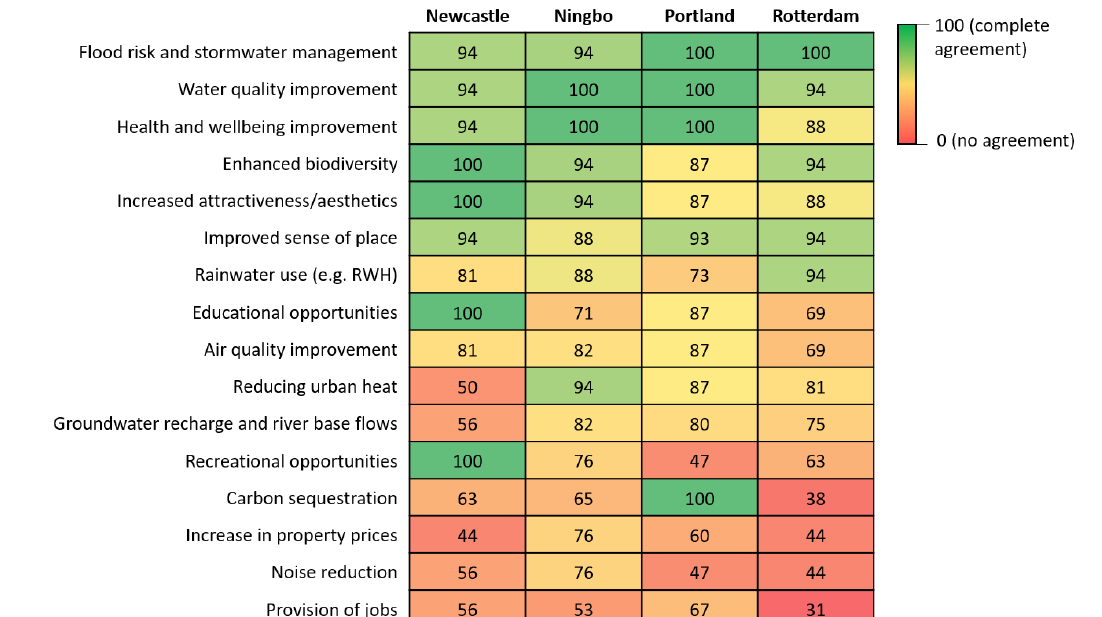
Figure 3. Median ranking of the water challenges by the whole sample population ( n = 64). Respondents were asked to rank the importance of each challenge in their city using a 1 (very important) to 10 (not important) scale; lower rankings denote greater importance of the challenge. The bars are in the order of median score. *Water quality deterioration also includes concern over river health.